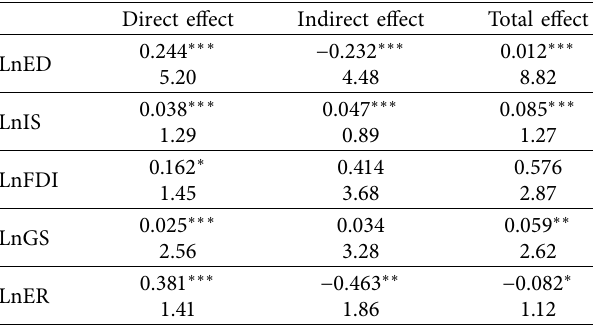
Table 9: Spatial spillover effects of green innovation